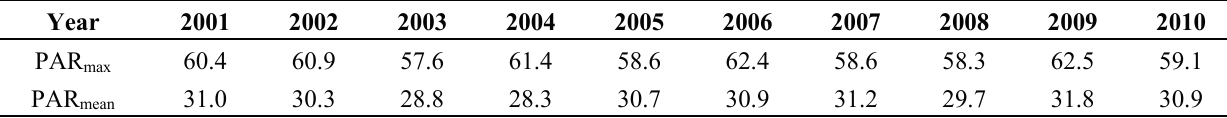
Table A2. The maximum and mean of photosynthetically active radiation (PAR) in mol·m − 2 ·day − 1 from 2001 to 2010 at the Puéchabon study site.